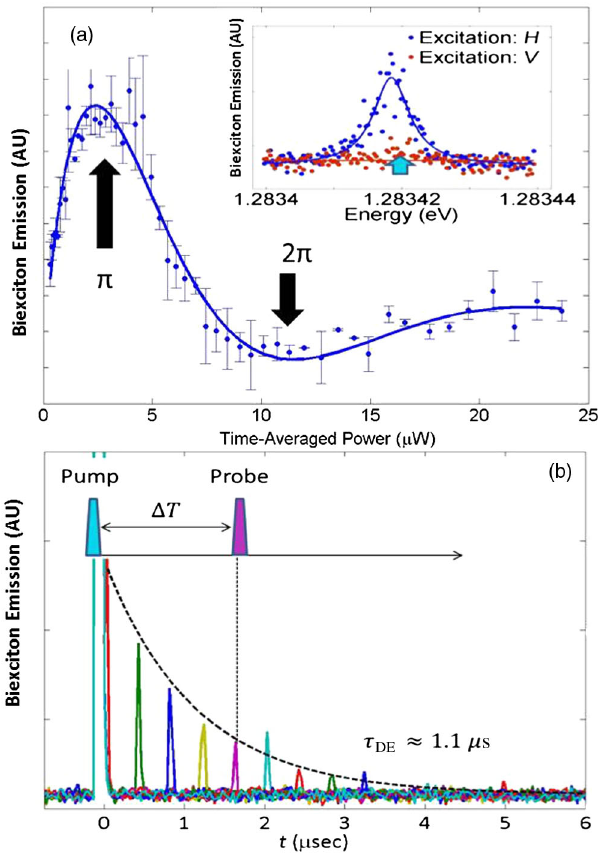
FIG. 4. Deterministic generation of the DE. (a) Lower-energy XX 0 biexciton emission intensity [Fig. 3(d)] as a function of T (cid:1) 3 the average resonant excitation power into the DE absorption resonance [Fig. 3(b)] with a pulse width of 60 nsec, in the presence of a probe laser tuned to the higher-energy XX 0 T (cid:1) 3 transition resonance [Fig. 3(c)]. The powers at which π and 2 π pulses are obtained are marked by vertical black arrows. The solid line represents a model fit of the Rabi oscillations. In the inset, the XX 0 biexciton emission intensity as a function of the energy of T (cid:1) 3 the H ( V ) linearly polarized excitation into the DE optical transition is depicted by the blue (red) dots. The energy used for resonant, deterministic excitation of the DE is indicated by a blue arrow. (b) Lifetime of the DE as measured by a time-resolved double resonant pump-probe experiment. The XX 0 biexciton T (cid:1) 3 emission is measured as a function of the time difference between the DE excitation π pulse and the XX 0 probe pulse. The inset T (cid:1) 3 describes the experiment sequence of pulses, where the DE is excited at time t ¼ 0 (blue pulse) and its population is probed via absorption of a time-delayed probe π pulse (magenta). The intensity of the resulting emitted light from the biexciton is a measure of the magnitude of the decaying DE population. The dashed black line is a fitted exponential decay model with characteristic DE lifetime of 1 . 1 μ